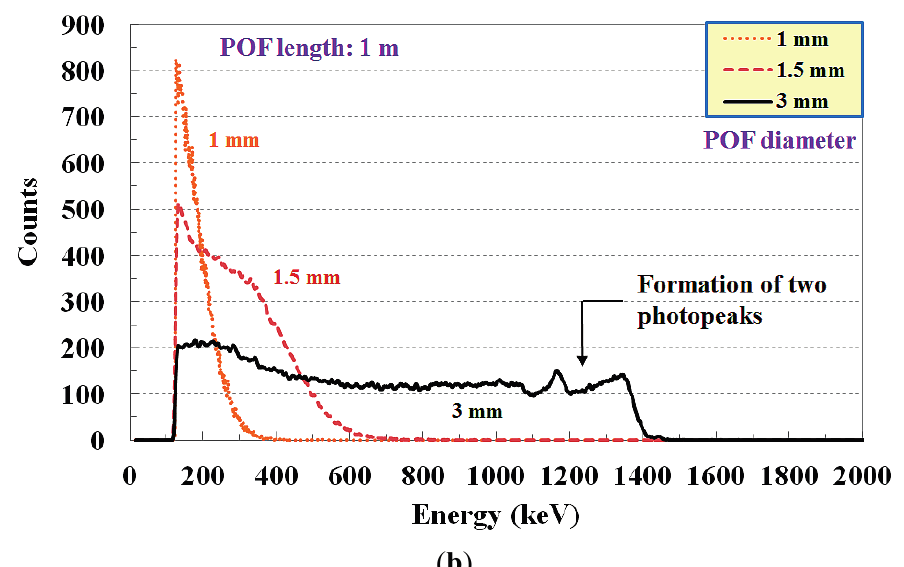
Figure 8. Variation of measured gamma-ray energy spectrum according to ( a ) the length and ( b ) the diameter of the